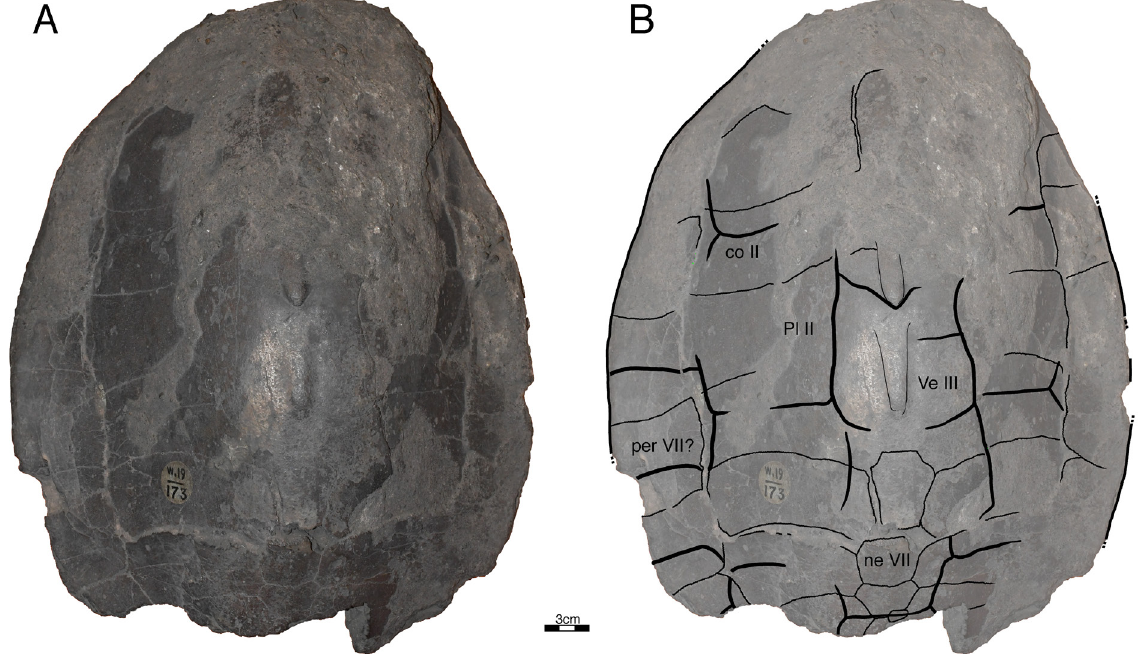
Fig. 15. IM W19/173, previously undescribed, here identified as Batagur dhongoka (Gray, 1832). A . Photograph of carapace. B . Illustration of carapace. Scale bar: 3